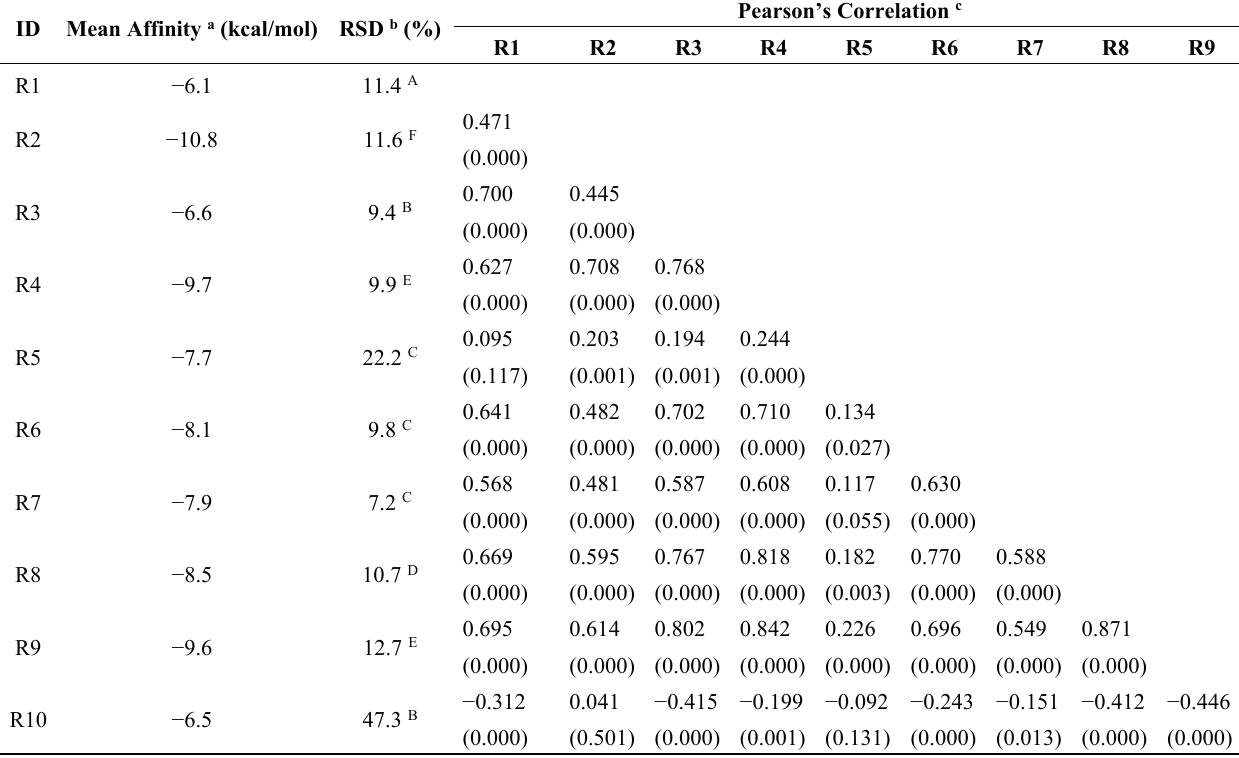
Table 3. Mean docking scores for each target enzyme and their Pearson’s